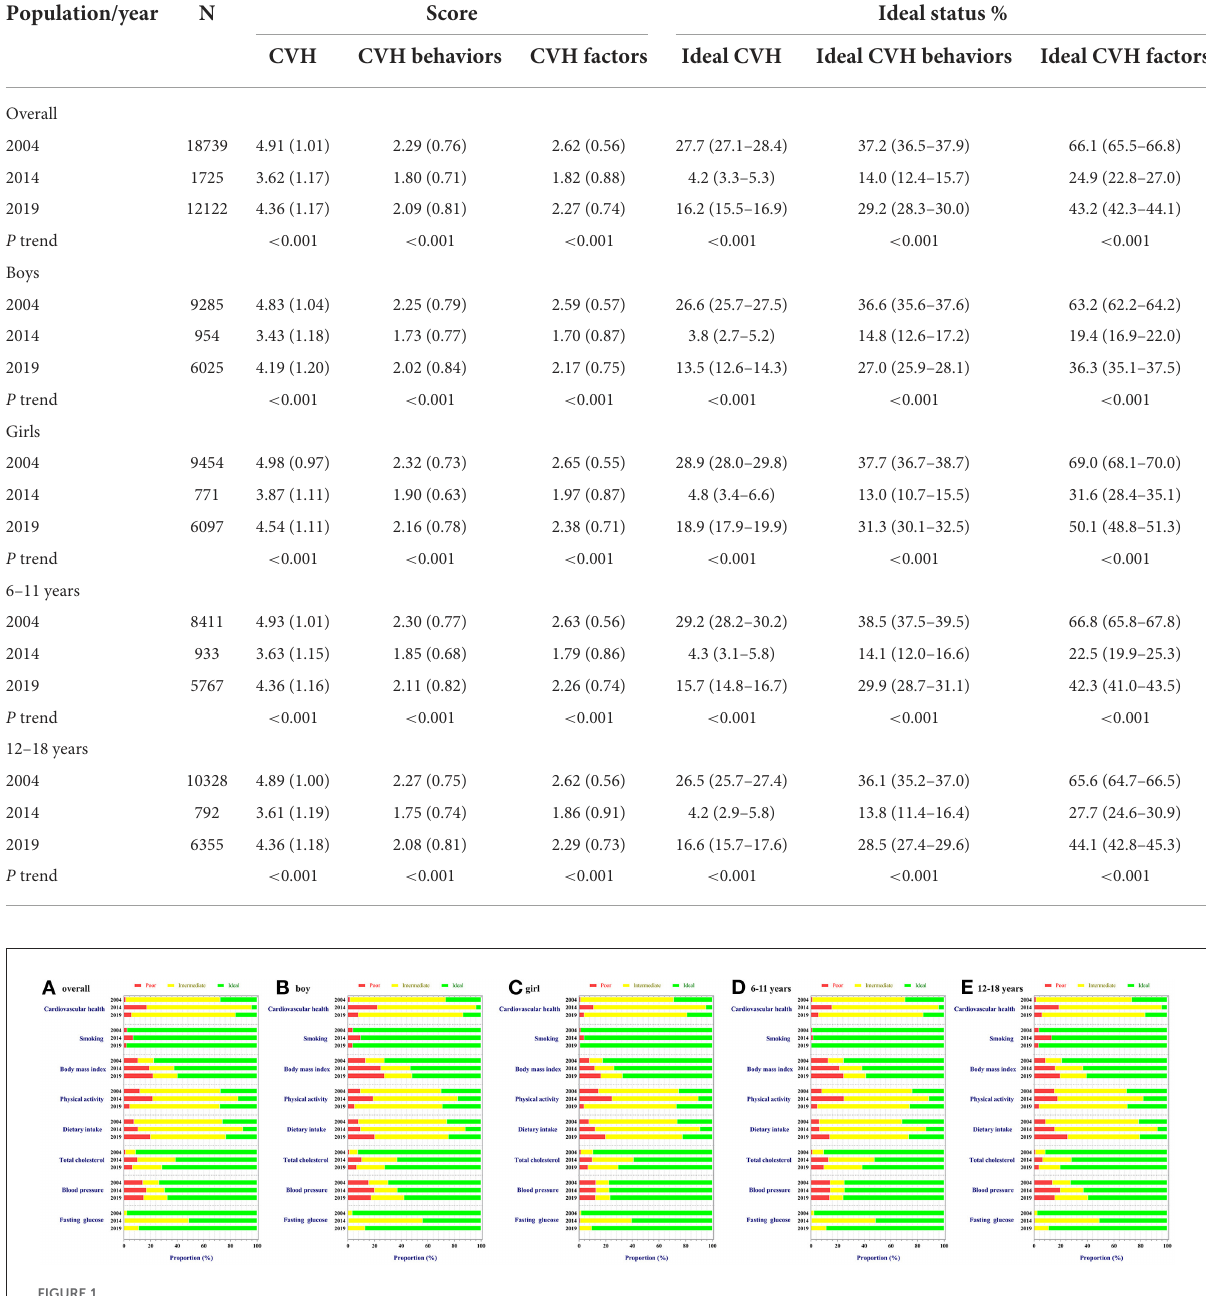
TABLE 3 Cardiovascular health score and prevalence of ideal cardiovascular health in total population and subgroups of sex and age: 2004–2019.